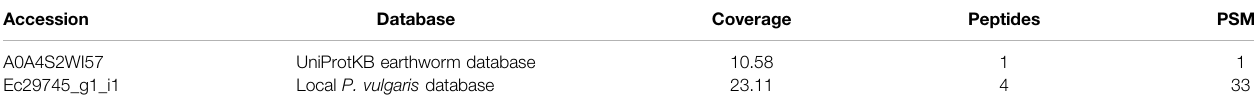
TABLE 2 | The identi fi ed proteins of EPF3 compared against UniProtKB earthworm database and the local P. vulgaris